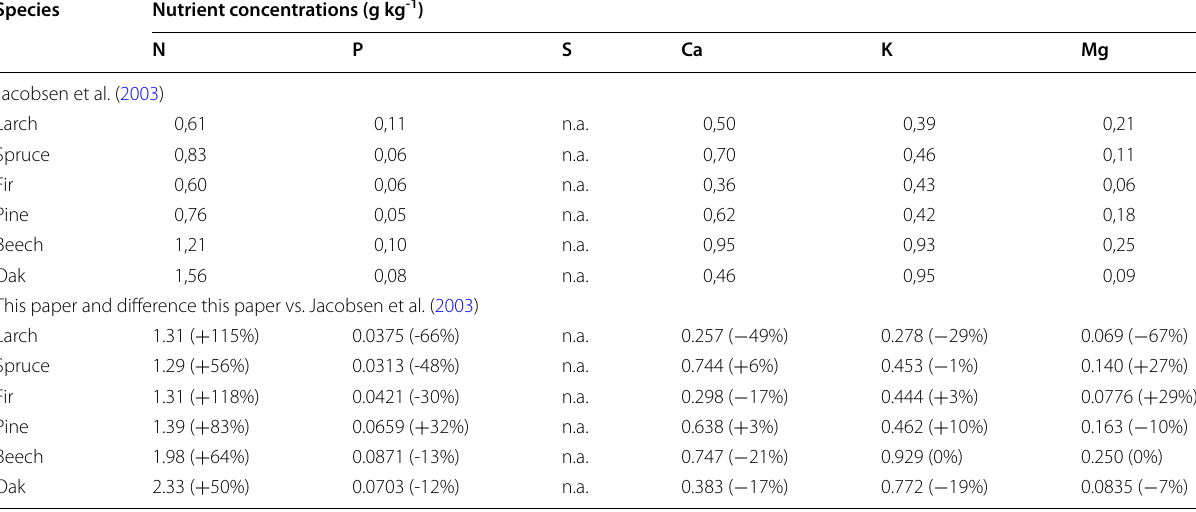
Table 14 Average nutrient concentrations in stem wood (without bark, g kg -1 ) according to Jacobsen et al. (2003) and this paper and relative difference (%) between both datasets (difference (%) this paper/Jacobsen et al. – 1) x 100%). Silver birch is not given in = Jacobsen et al. (2003). Japanese larch, Douglas firs, Scots pine and common oak are calculated from mass proportions of sapwood and